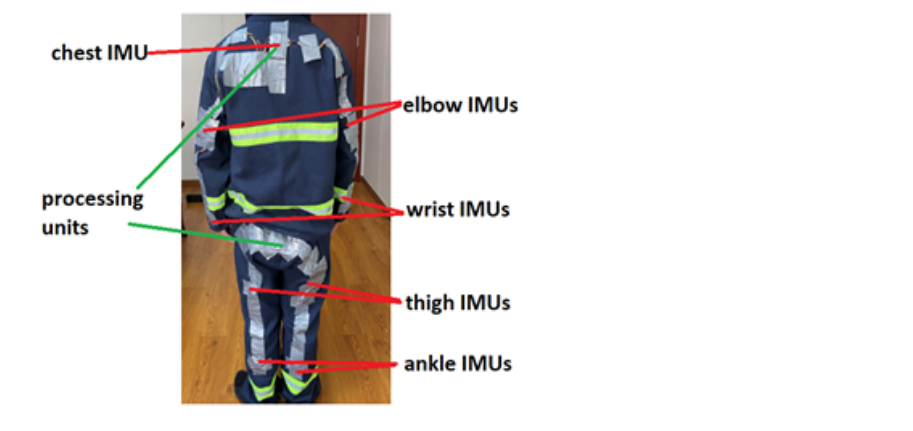
Figure 3. Placement of motion sensors that are mapped to the body parts where the motion data are critical for fall-detection computation.